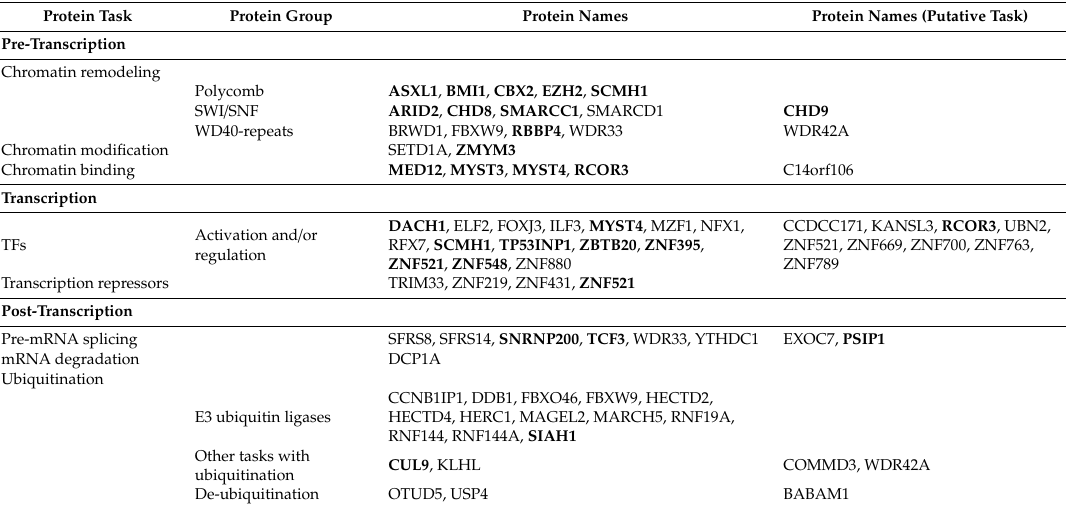
Table 3. Overview over the 75 transcription-associated proteins that were found to be overexpressed in TLR non-responding patient cells. Proteins in bold have been studied or identified as overexpressed in AML. Protein Task Protein Group Protein Names Protein Names (Putative